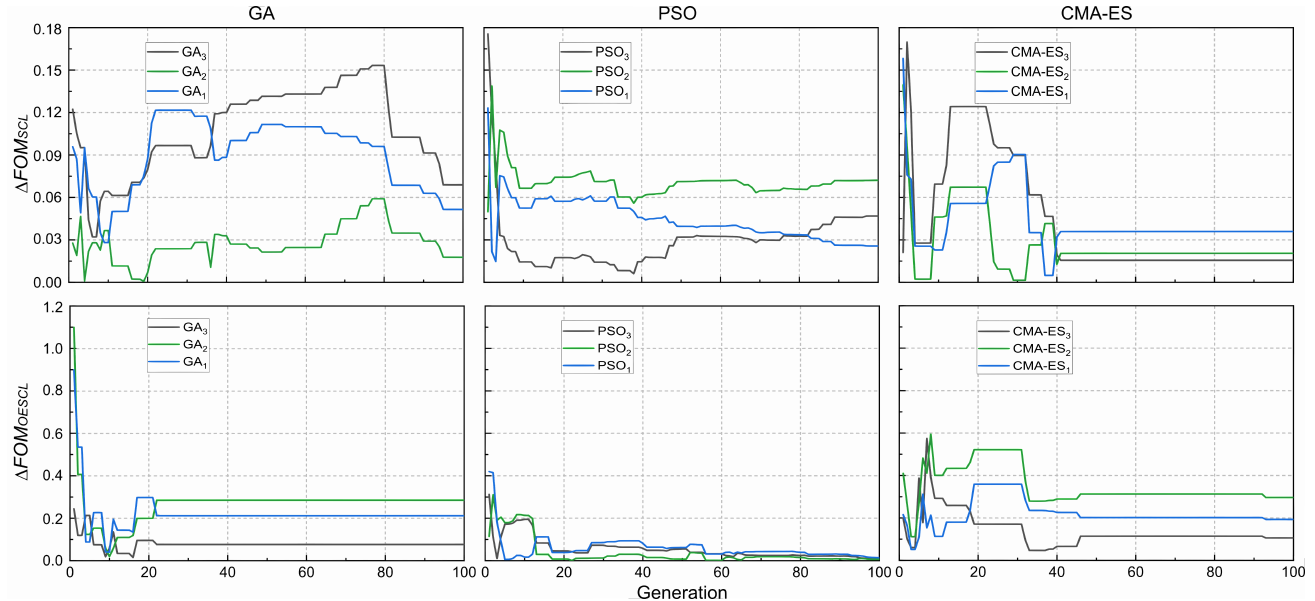
Figure 4. Similarity of the FOM for each algorithm (GA, PSO, and CMA-ES) in every optimization process. ( Top ) SCL-band. ( Bottom ) OESCL-band.